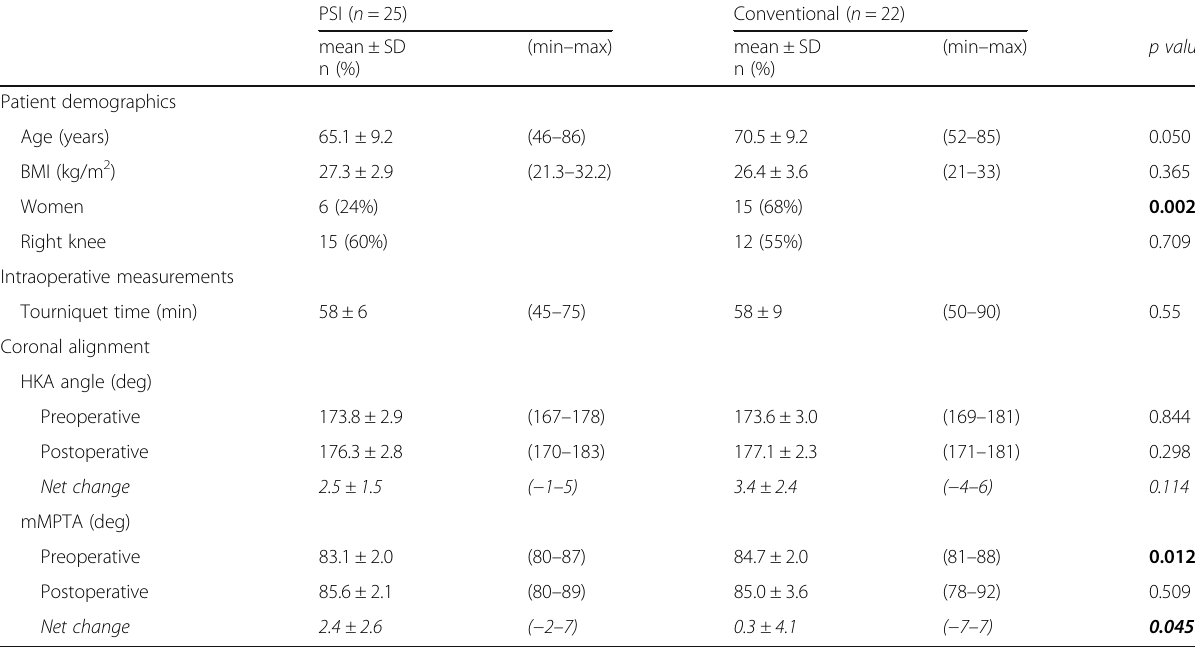
Table 1 Comparison of UKA using PSI versus using conventional instrumentation for tibial resections PSI ( n =